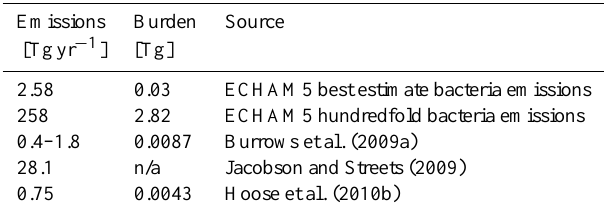
Table 4. Global bacteria emissions and burden calculated with ECHAM5 compared to the model results by Burrows et al. (2009a), Jacobson and Streets (2009) and Hoose et al. (2010b).